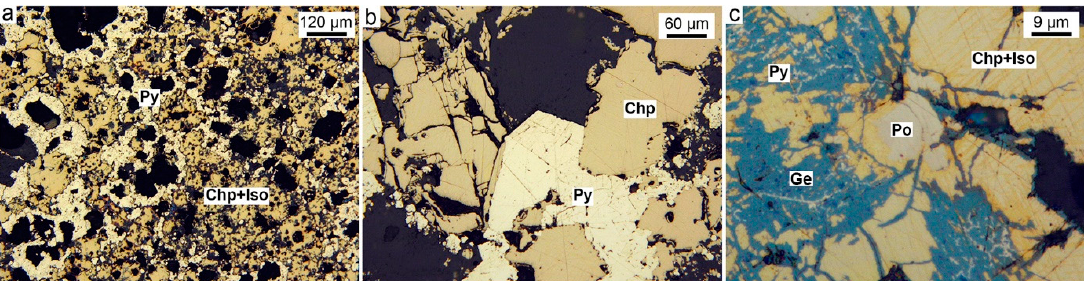
Figure 2. Isocubanite–pyrite microfacies. Pobeda-2 and Pobeda-1 hydrothermal fields. ( a ) Atoll-like aggregates of unzoned pyrite (Py) in chalcopyrite–isocubanite (Chp-Iso) aggregate (sample 107-2); ( b ) unzoned subhedral crystals of pyrite (Py) in the cavity of chalcopyrite–pyrite (Chp) aggregate (sample 204d-4); ( c ) inclusion of pyrrhotite (Po) in chalcopyrite–isocubanite (Chp-Iso) aggregate in association with geerite (Ge) and veinlets of the latest pyrite-related (Py) to the chalcopyrite alteration to geerite. Reflected light.